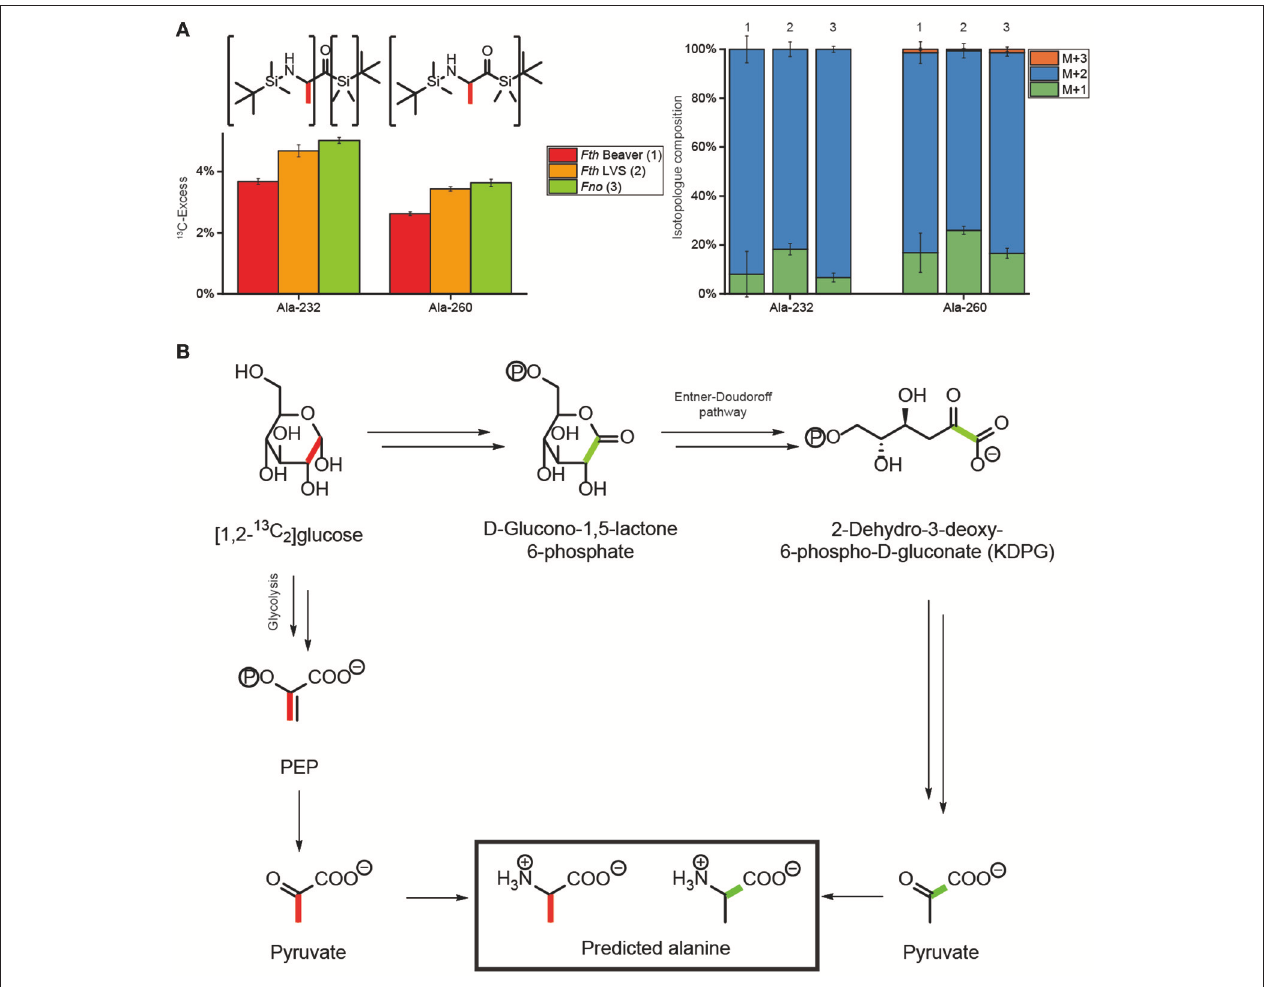
FIGURE 3 | Transfer of 13 C-label from [1,2- 13 C 2 ]glucose into alanine of Fth Beaver (1), Fth LVS (2), or Fno (3). (A) 13 C-Excess (mol%) and the fractional isotopolog distributions (%) in the silylated fragments Ala-260 and Ala-232 carrying C1-C3 and C2-C3 of the original alanine carbon chain, respectively. (B) Conversion of [1,2- 13 C 2 ]glucose into pyruvate and alanine via glycolysis (EMP) (left, with red bars indicating the 13 C-labels) or the Entner-Doudoroff pathway (ED) (right, with green bars indicating the 13 C-labels). The observed label distribution with 13 C at C2 and C3 (indicated by red bars in panel A ), only matches the predicted pattern via the EMP in panel (B) . For more details, see also